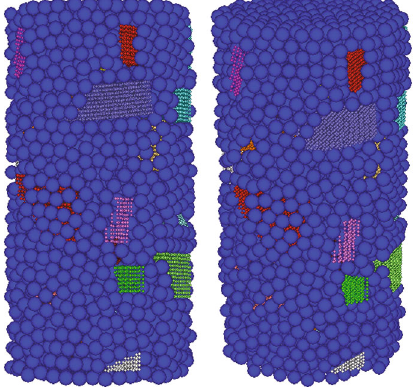
Figure 8: Discrete element sample of triaxial